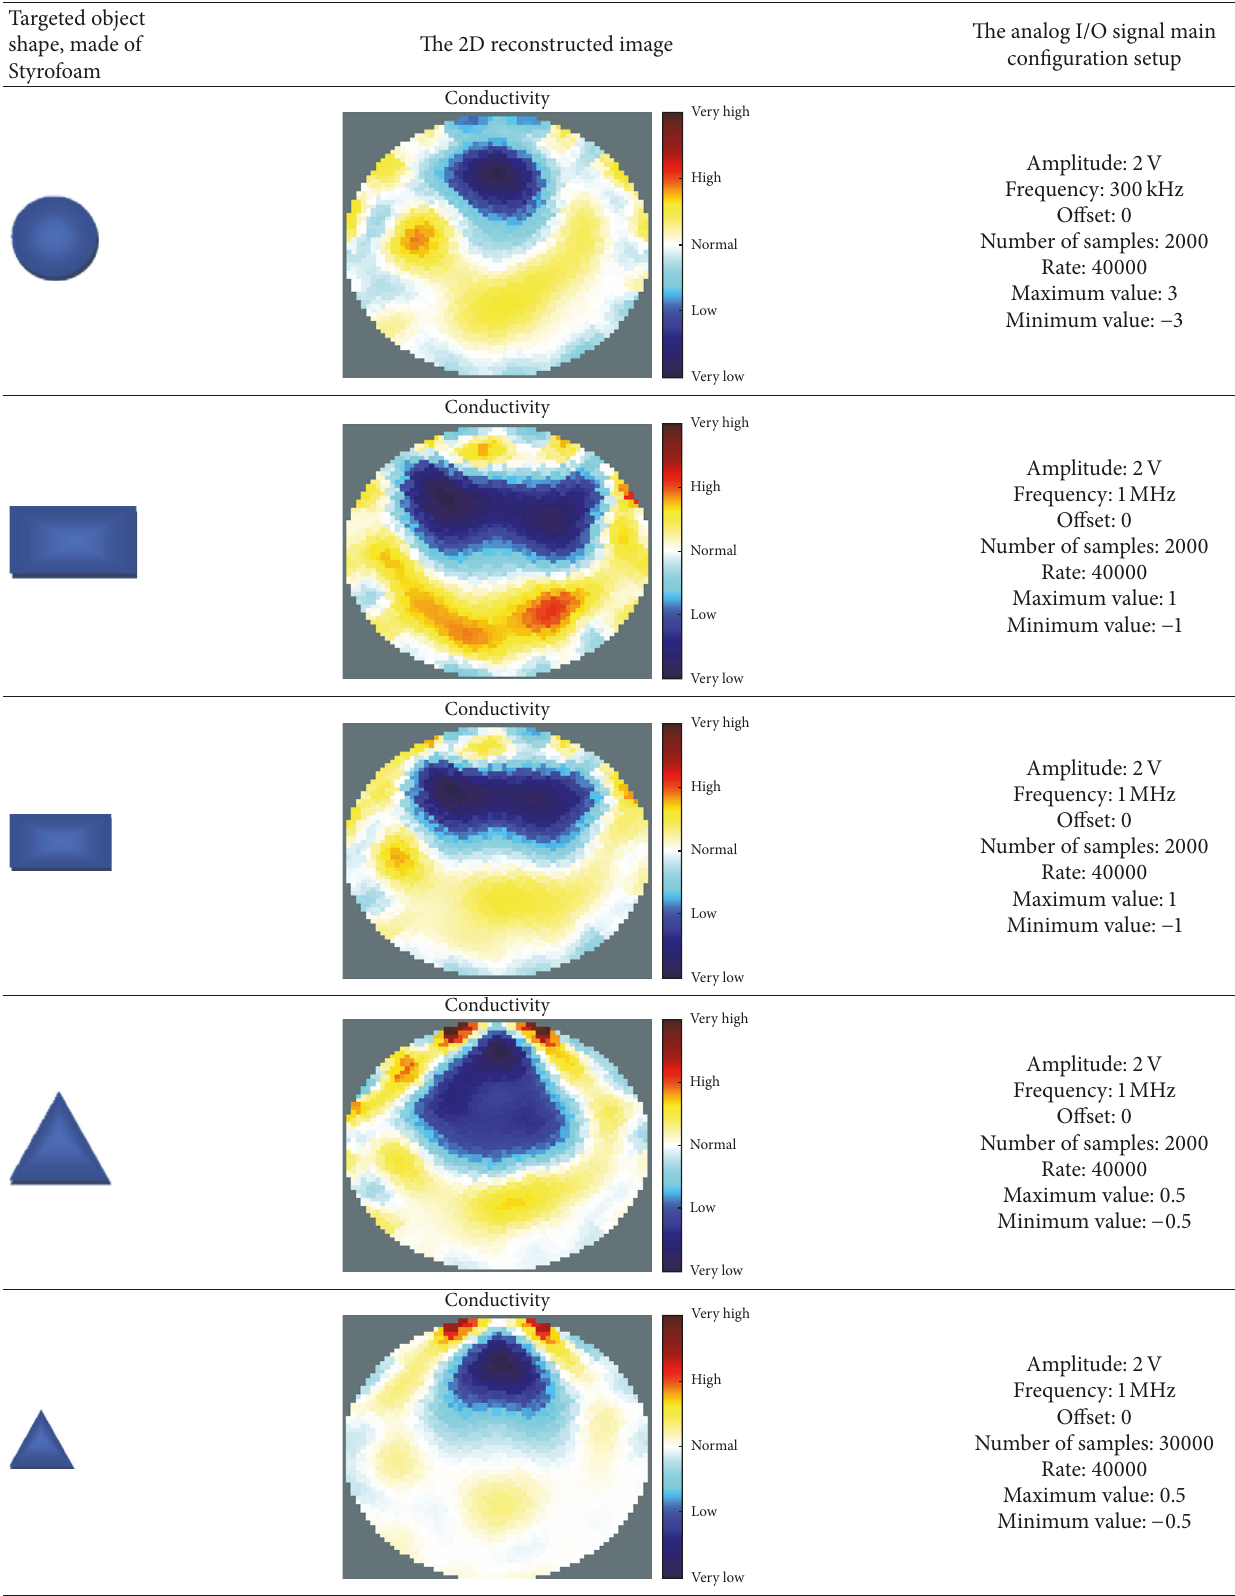
Table 6: Nonconductive objects (Styrofoam) with different shapes; reconstructed images for different nonconductive object shapes. Targeted object shape, made of